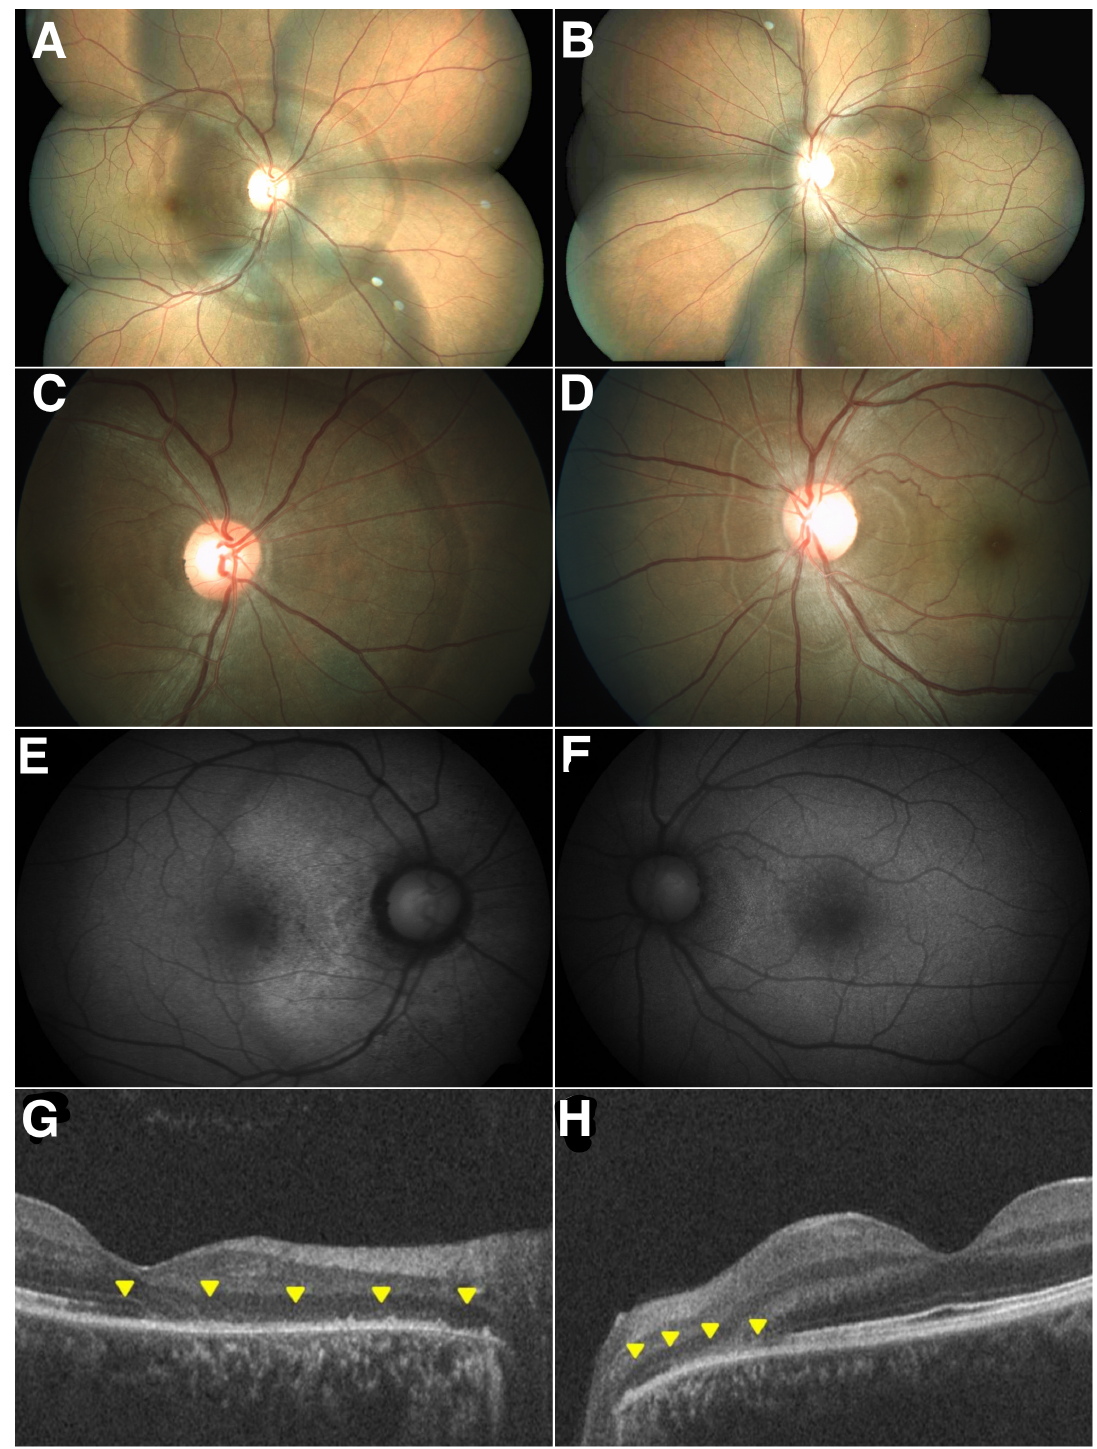
Figure 1: Colour fundus montage of the right (A) and left eye (B) shows a greyish opacification of the peripapillary retina; with more details of the posterior pole (C, D). FAF imaging reveals a speckled hyper-autofluorescence denoting an active disease phase and a speckled hypo-autofluorescence indicating RPE atrophy (E, F). OCT reveals a zonal loss of the outer retinal layers with a disruption of the photoreceptors (arrows; G,